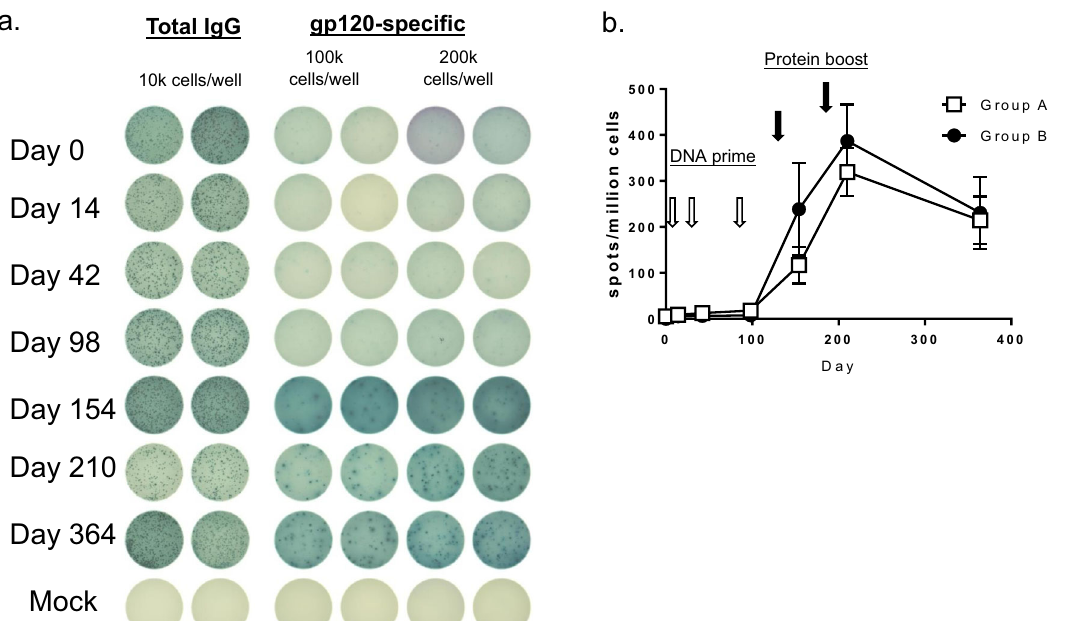
Fig. 5 B cell ELISPOT was used to measure the gp120-speci fi c memory B cell responses in DP6-001 volunteers. A mixture of fi ve autologous gp120 proteins same as used in DP6-01 vaccine was coated on the plates. a ELISPOT readouts in duplicate from one volunteer sample collected at different time points of vaccination course are shown. b The dynamics of gp120-speci fi c memory B cell responses is shown as the group average in spot/1 million cells with standard error.